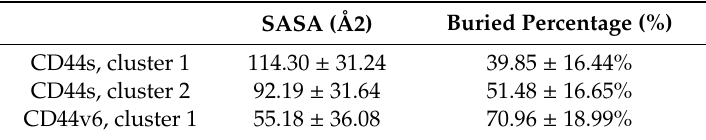
Table 2. Solvent-accessible surface area (SASA) for the side chain of the Phe215 in CD44s and CD44v6. All values are presented as mean ±